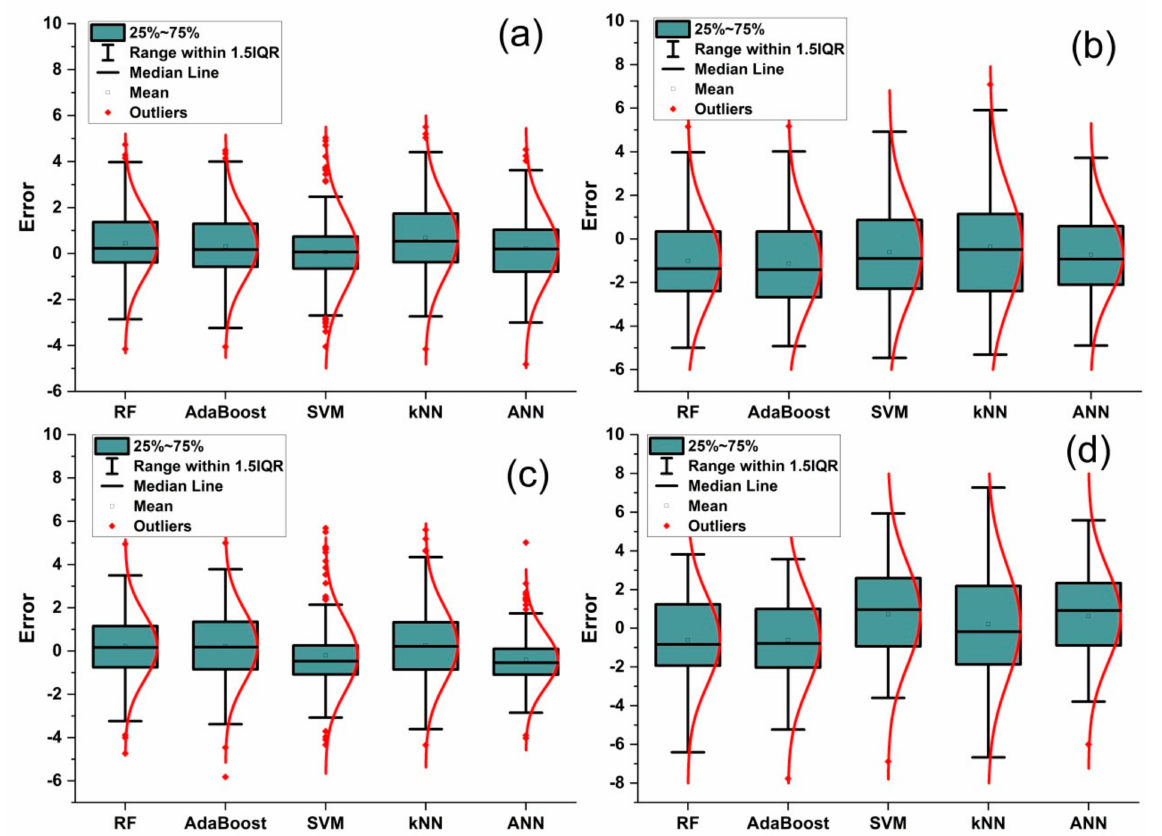
Figure 5. Distribution of the model errors during the simulation of the suspended sediment load recorded in 2021, namely random forest (RF), adaptive boosting (AdaBoost), artificial neural network (ANN), and k-nearest neighbor (kNN). Red lines represent the fitted normal distributions of the error, and points outside the box plots are the outlier values of the errors. ( a ): at Aguibat Ziar station; ( b ): at Ras Fathia station; ( c ): at SM Cherif station; ( d ): at Ain Loudah station.